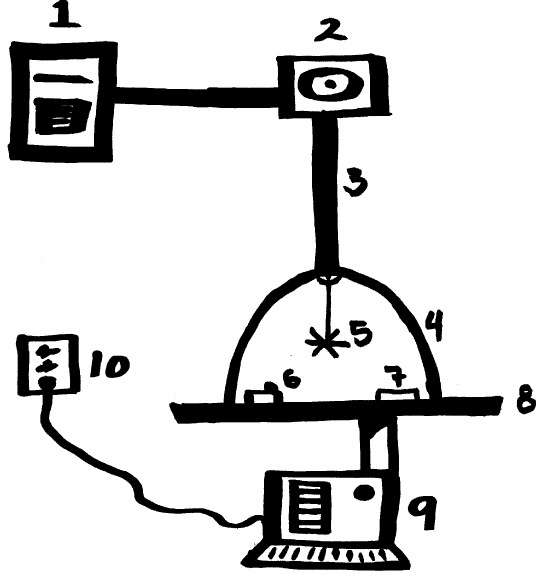
Fig. 2. Diagram of the fog simulation setup (1) computer, (2) elec- tronic scale, (3) nylon line, (4) chamber, (5) Tillandsia recur- vata sample, (6) humidity and temperature sensor, (7) petri dish, (8) metallic base, (9) humidifier, (10)